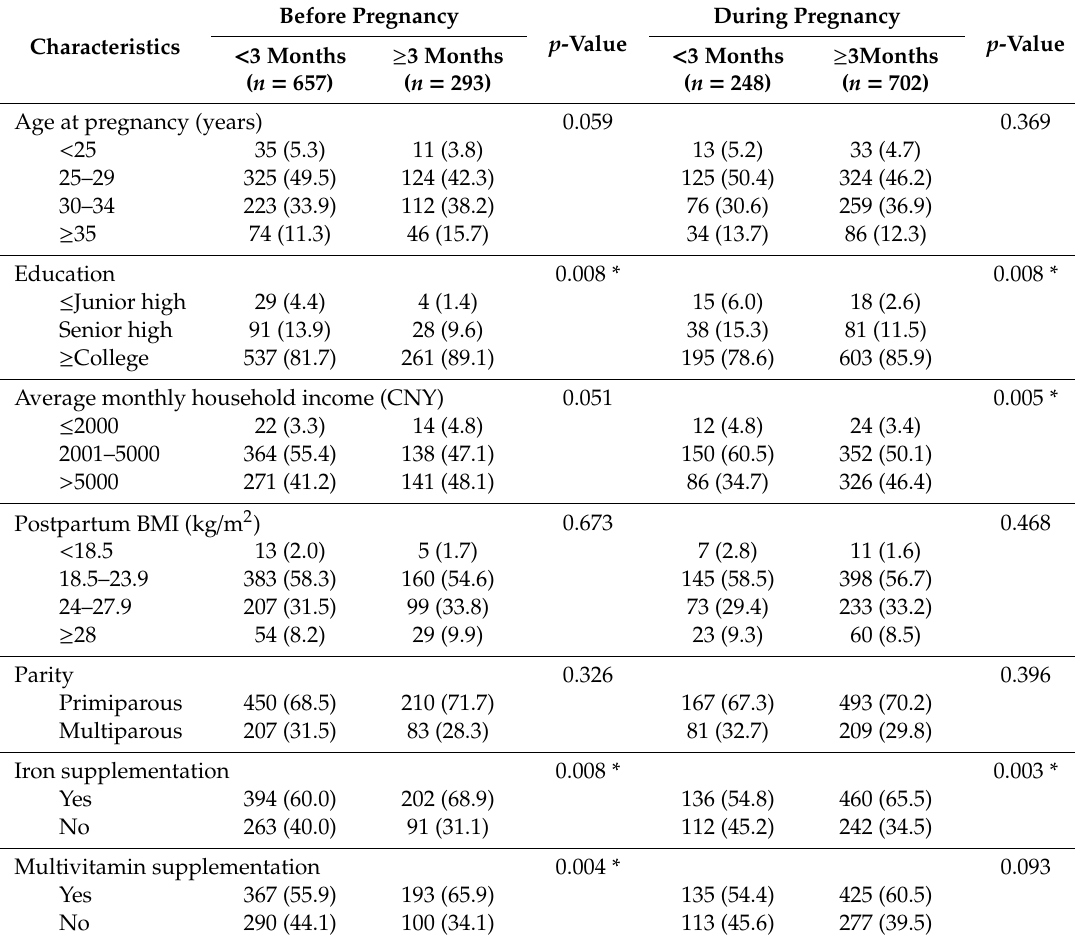
Table 1. Maternal characteristics according to the duration of folic acid supplementation in the cohort ( n =